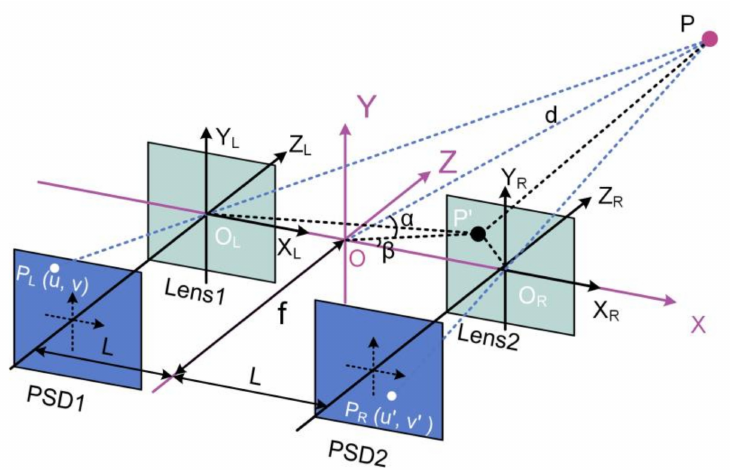
Figure 4. Binocular vison system based on dual PSD cameras.